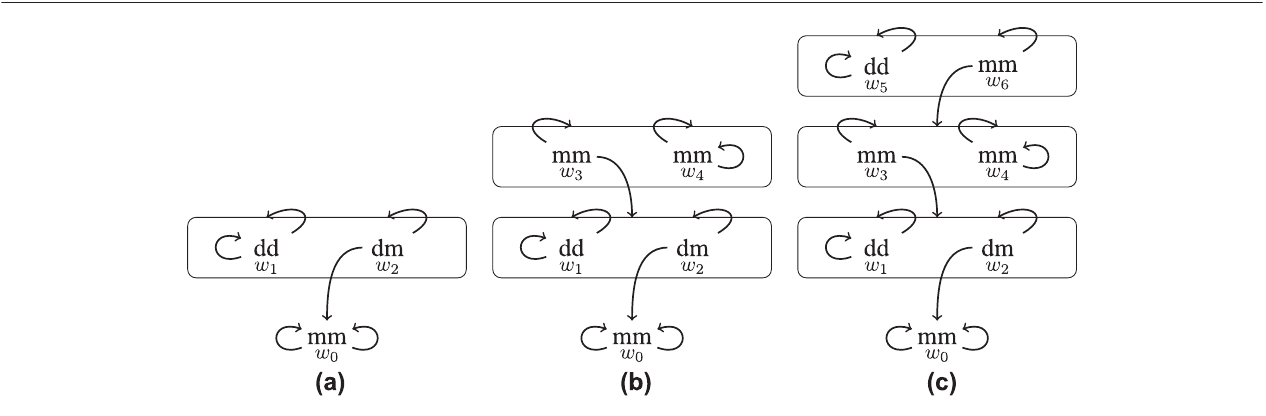
TABLE 11 | Graphs with circular belief states at higher